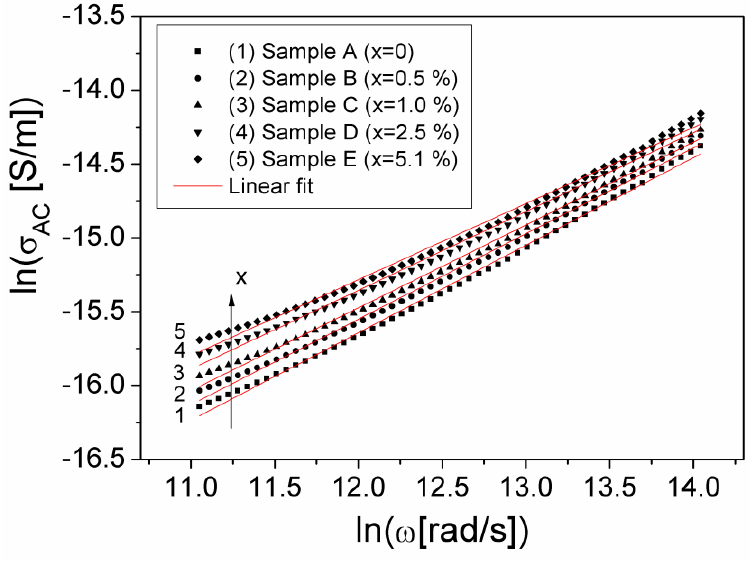
Figure 9. The ln σ AC (ln ω ) dependence at different volume fractions x of Al particles of the samples. The experimental dependence ln( σ AC )(ln( ω )), from Figure 9, was fitted with a straight line, thus being able to determine both the parameter A 0 and the exponent n, corresponding to each sample, the obtained values being showed in Table 1. From Table 1, it is observed that the exponent n decreases slightly, from 0.593 for sample A (x = 0) to 0.515 for sample E (x = 5.1%). This low variation of n indicates a constant dispersion of σ AC conductivity with frequency by increasing the volume fraction of Al particles from samples (see Figure